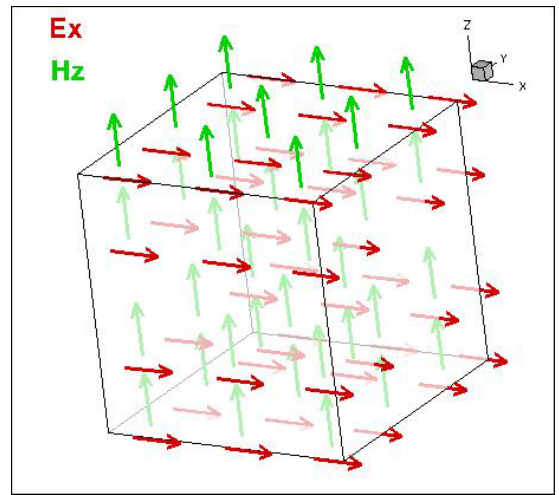
Figure 1: Repartition of the degrees of freedom: E x compo- nent (red) and H z component